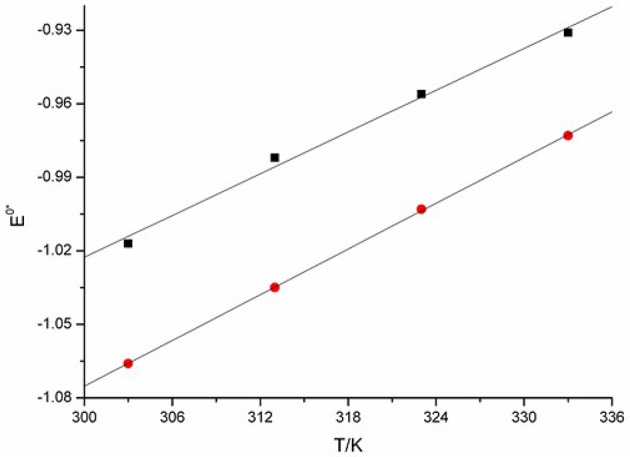
Plots of EEu(III)/Eu(II)0* against T measured in [C4mim][N(CN)2] (black), and [C4m2im][N(CN)2] (red).